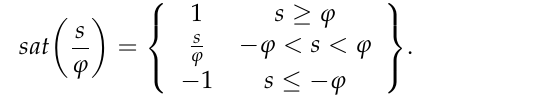
Figure 11. Foot reference